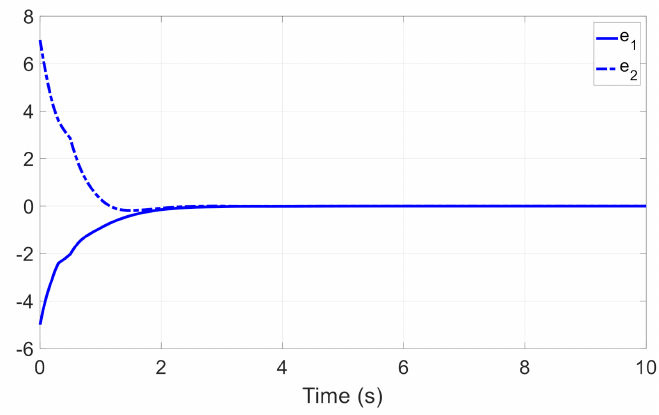
Figure 10. The estimated error of the